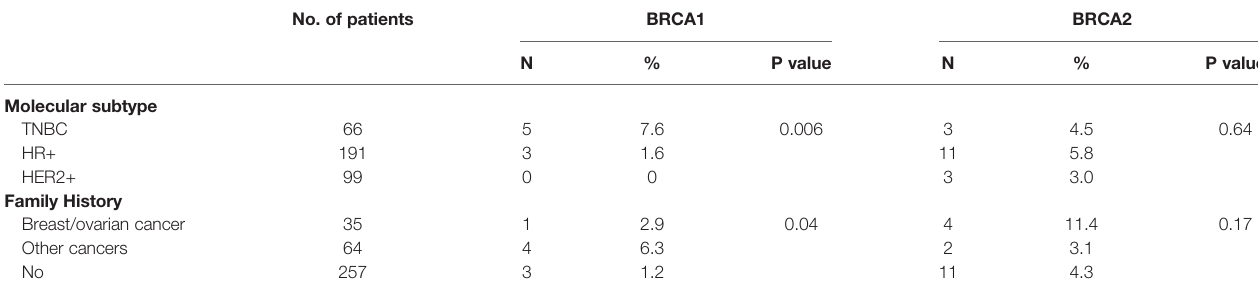
TABLE 3 | Mutation rates of BRCA1/2 in different molecular subtypes and family